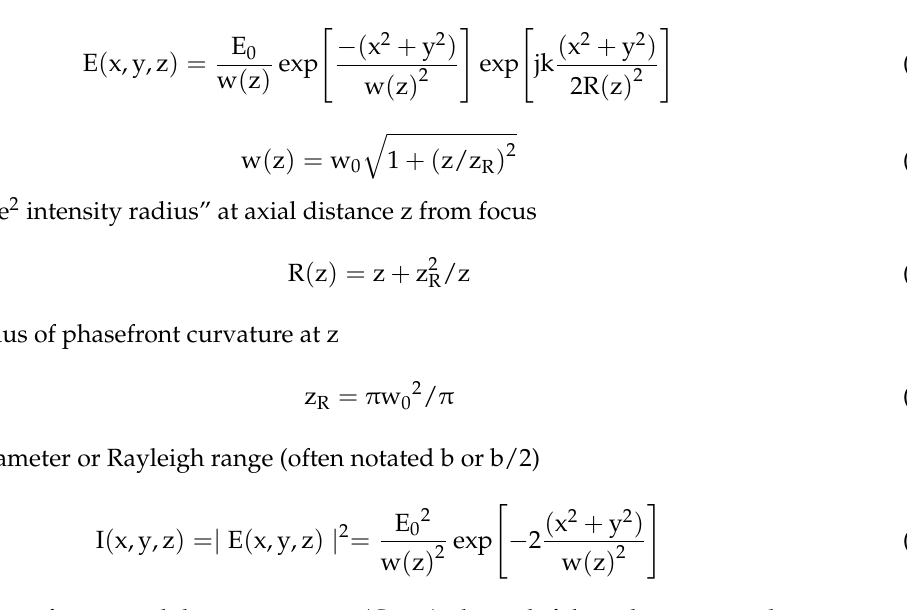
Figure 3. Two models for heterodyne lidar collection efficiency. ( a ) Normalised curves of range dependence for three different fixed focus ranges (50 m, 100 m, 200 m). Lorentzian (solid lines): efficiency scales as the reciprocal of beam area. Lindelöw (dashed lines): modified Gaussian optics/ray optics model proposed by Lindelöw [4]; ( b ) The quotient (Lorentzian efficiency)/(Lindelöw efficiency) for a fixed target range of 100 m and a varying focus range. Wavelength 1.575 μ m, equivalent fibre core beam radius 4.5 μ m, and lens focal length 200 mm (roughly representative of QinetiQ/ZephIR lidar).